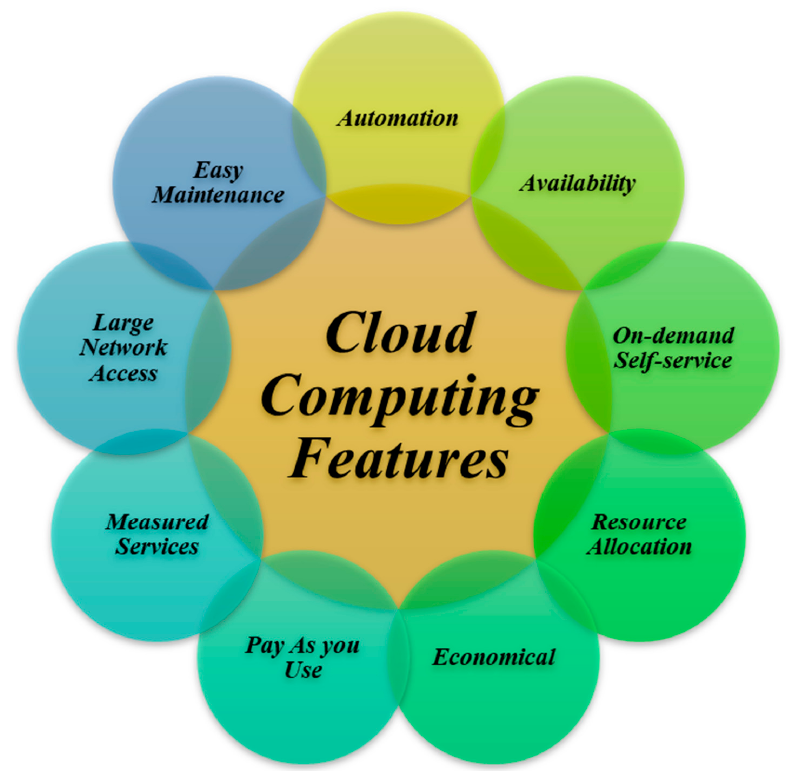
Figure 5. Cloud computing features.